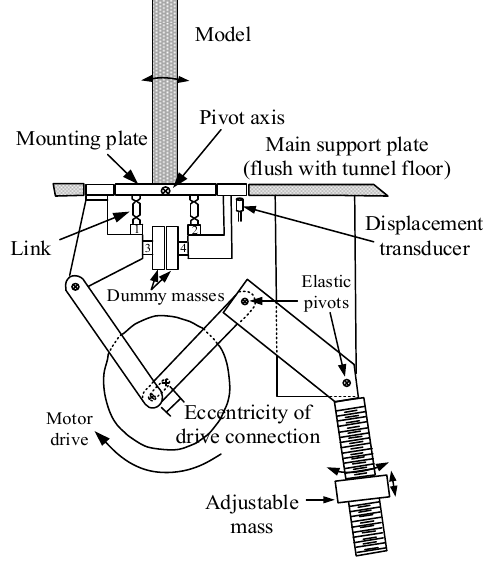
Figure 2. A forced vibration test with respect to base force measurement [27].